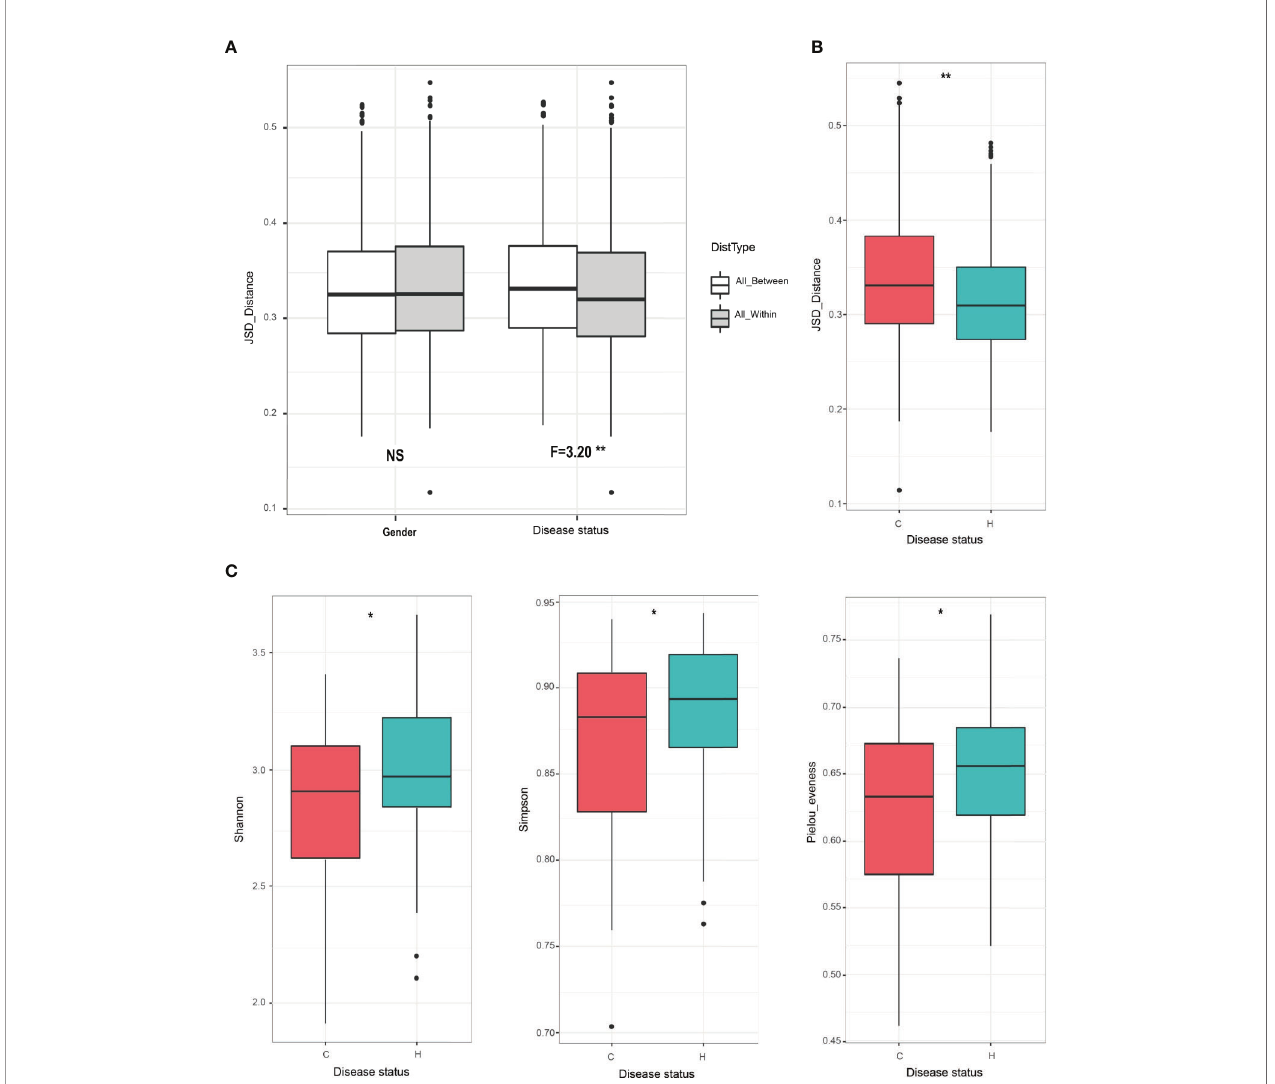
FIGURE 2 | Oral microbial diversity comparisons between caries and healthy children in Qingdao cohort. (A) Salivary microbiota variation was compared within and between disease status (i.e., H or C), or gender based on the Jensen-Shannon distances. Only disease status exhibits a strong effect on the composition of saliva microbiota (F=3.20**). (B) Caries-free children have more conservative microbiota than do children with caries (** p <0.01). (C) Alpha diversity comparisons between the C and H groups using on Shannon, Simpson, and Pielou ’ s evenness index. Indices showed that, the alpha-diversity values from the caries-affected samples were signi fi cantly decreased than those in healthy samples (Shannon, * p= 0.041; Simpson, * p= 0.046; Pielou ’ s evenness, * p=